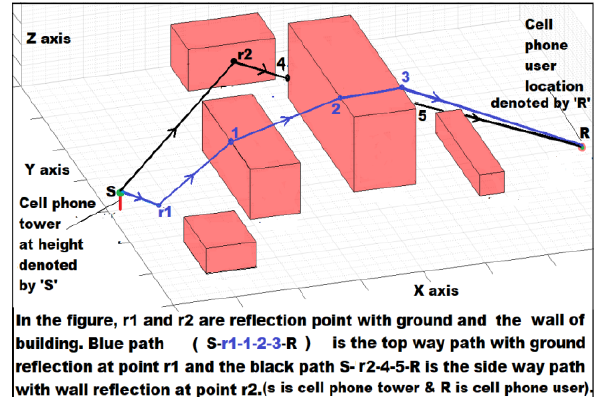
Figure 12. Signal path due to reflection